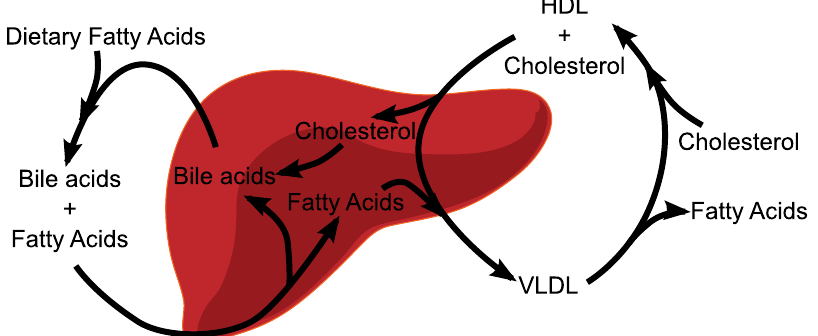
Figure 7. The liver regulates two tightly coupled pathways: bile acid synthesis and fatty acid metabolism. Abbreviations: VLDL: very low-density lipoprotein, HDL: high-density lipoprotein.